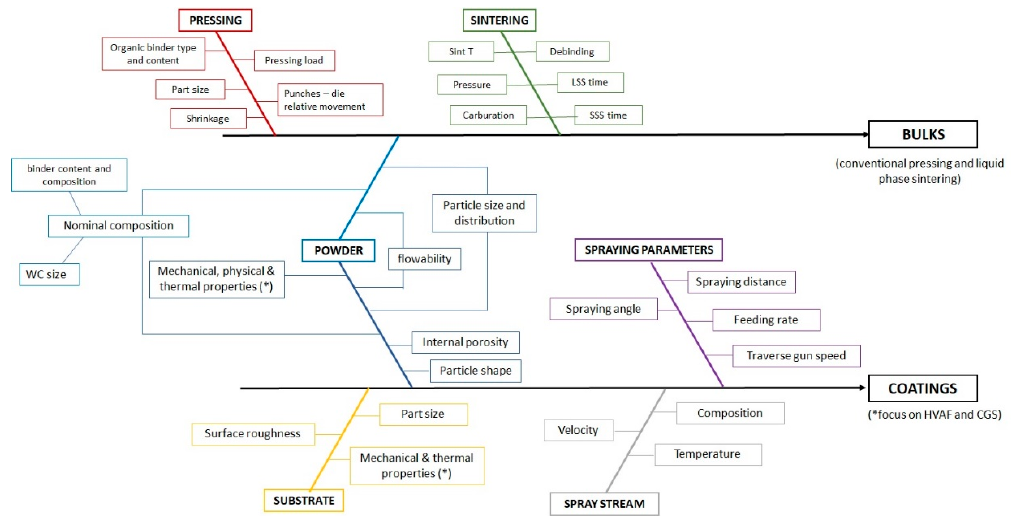
Figure 1. Fishbone analysis of variables affecting production of cemented carbide bulk and coatings. The factors with an asterisc (*) may be critical for HVAF and CGS spraying but may not be that much for other thermal spraying techniques.